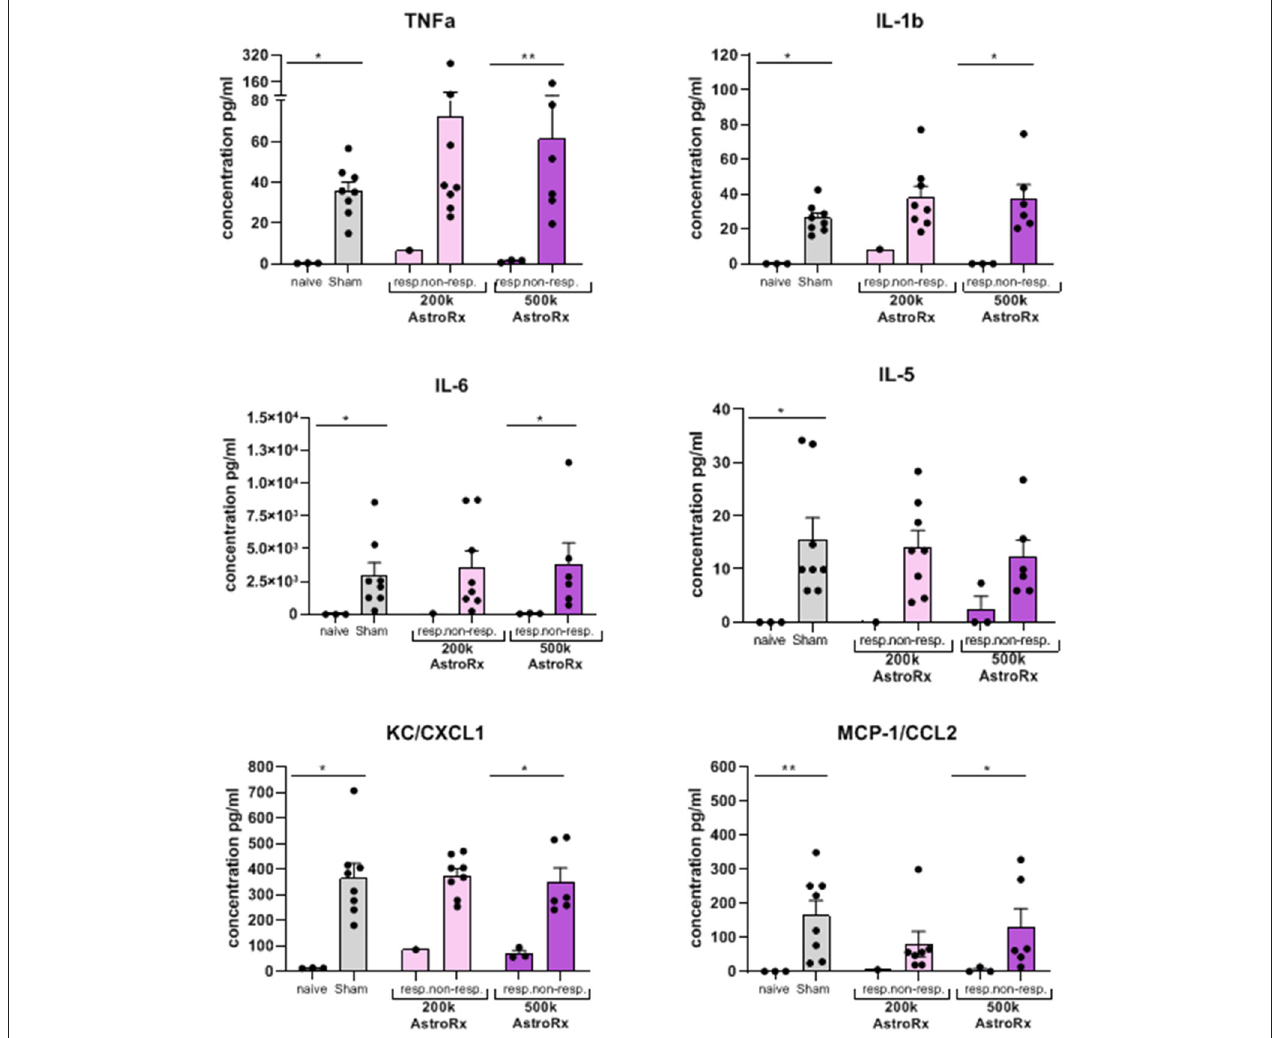
FIGURE 6 | Inflammatory cytokines/chemokines in the lungs are held in check in responder mice treated with AstroRx cells. The cytokines and chemokines in the BALF were quantified by ELISA. The value of n = 10 mice for each experimental group (sham and both the groups of AstroRx treated mice) and n = 4 for naïve mice, the results are expressed as mean ± SEM. The Mann–Whitney comparison test. * p < 0.05; ** p < 0.01; naïve vs. sham: * p = 0.0121 (for all cytokines/chemokines), 500K responders vs. non-responders: ** p = 0.0091 (TNFa), * p = 0.0286 (IL-1b, IL-6, CXCL1, and